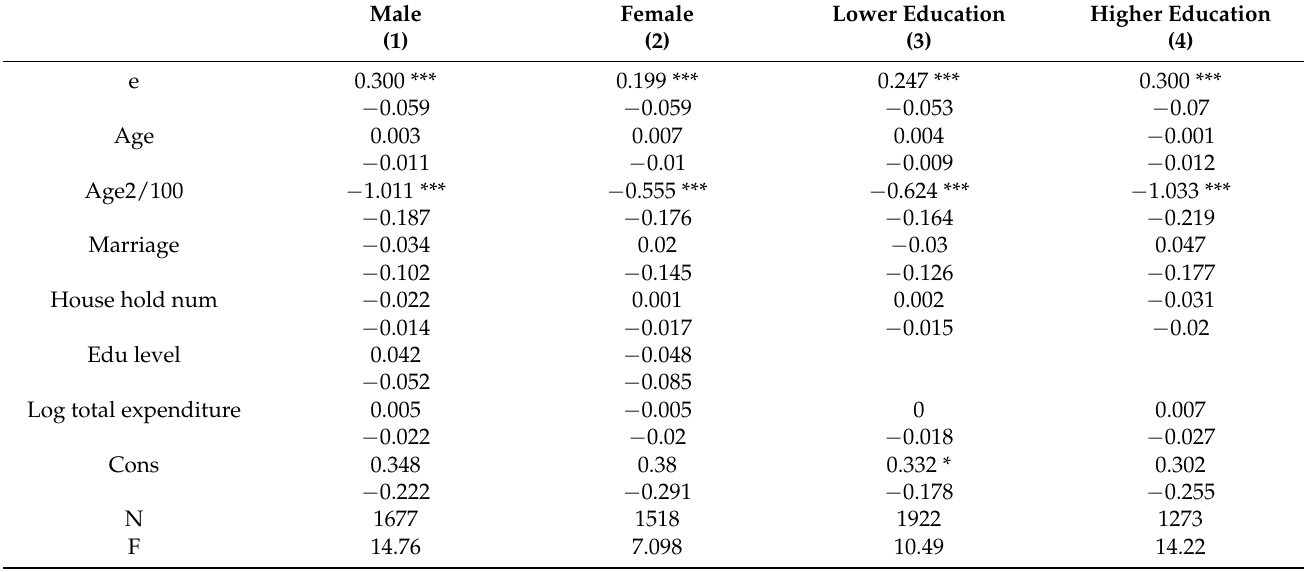
Table A3. First stage estimation results by gender and education of being retired.